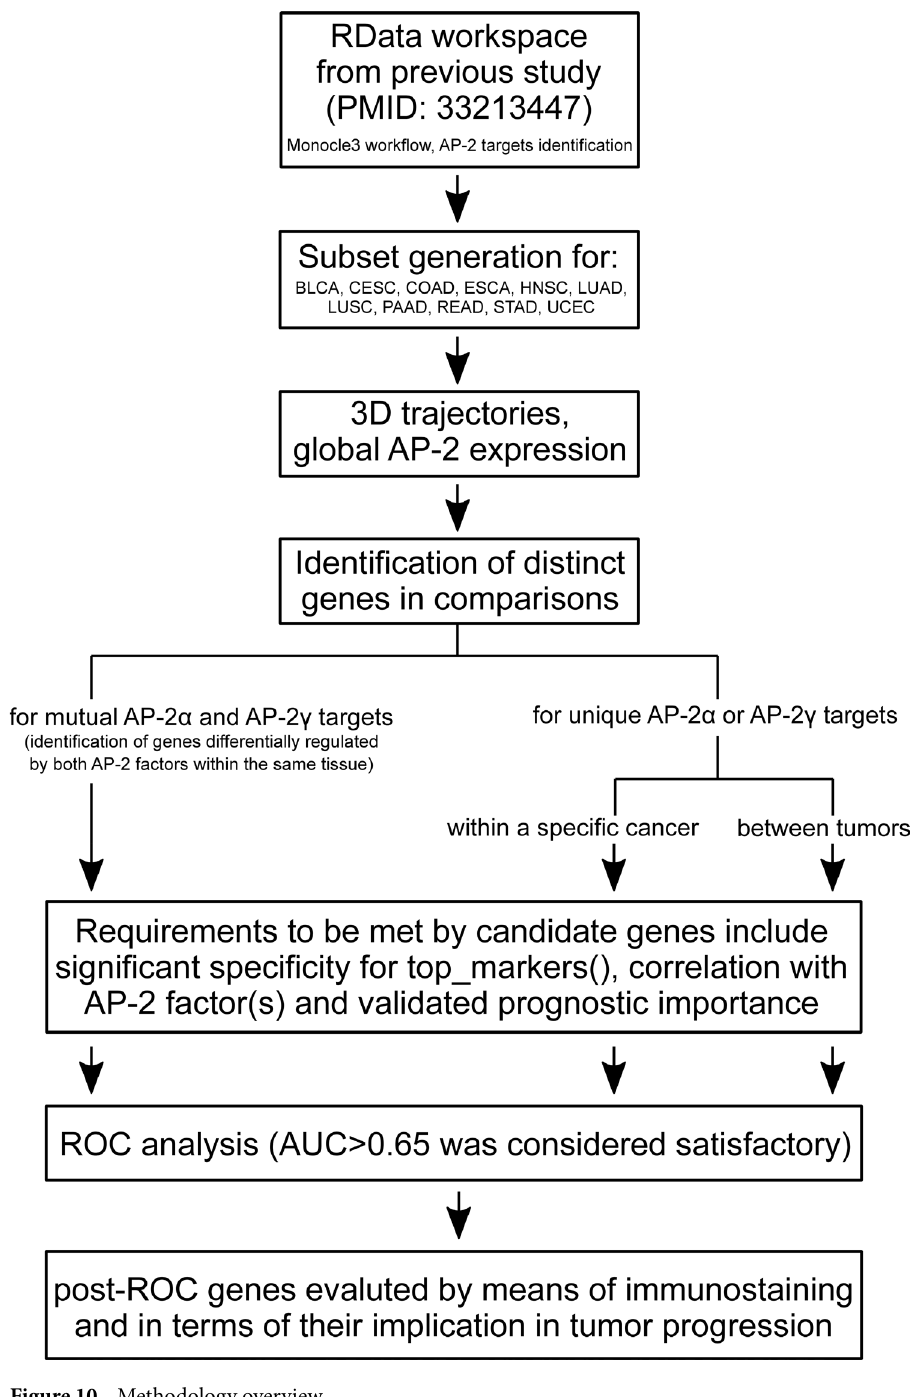
Figure 10. Methodology